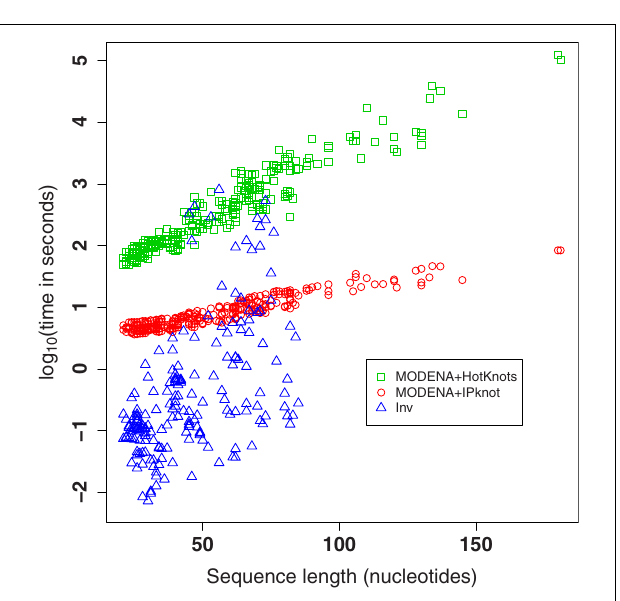
FIGURE 4 |The logarithm of the computational times needed for the Pseudobase benchmark of MODENA + IPknot, MODENA + HotKnots, and Inv. Each symbol corresponds to one target structure. Each computational time for Inv is the mean over fifty independent runs.The results of failed Inv runs are not included in this